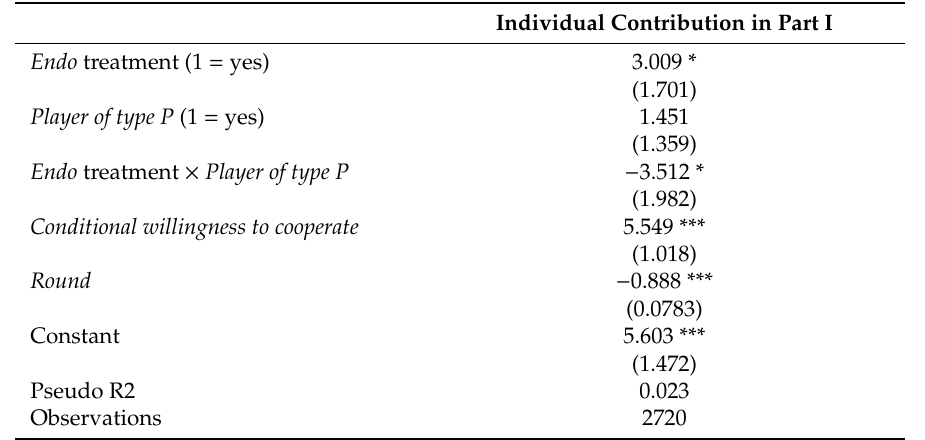
Table 3. Tobit estimations on individual contributions in part